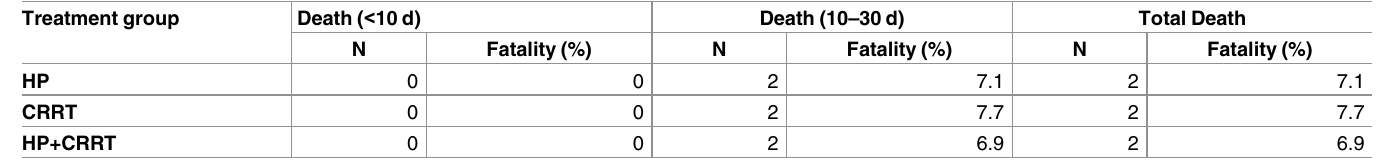
Table 4. Fatality times and rates of paraquat-poisoned patients with low plasma paraquat levels (50–1,000 ng/mL, n = 83). Treatment